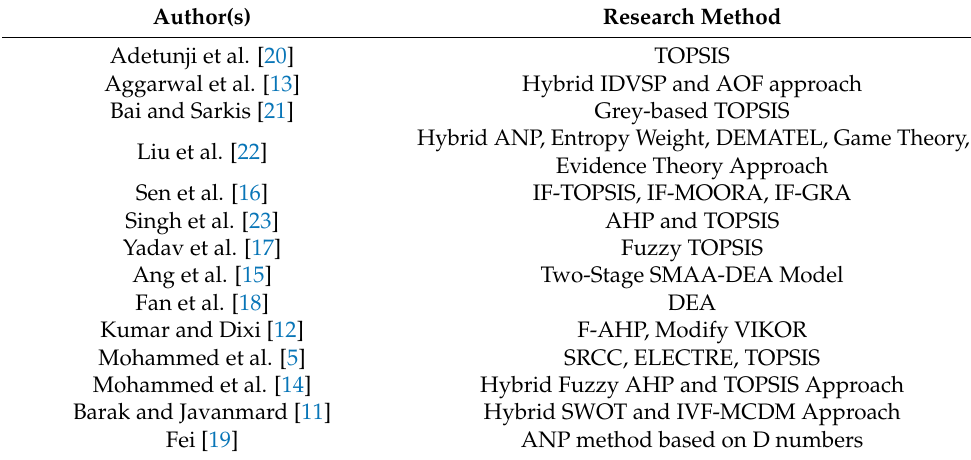
Table 1. Summary of available hybrid multiple criteria decision-making (MCDM) approaches for supplier